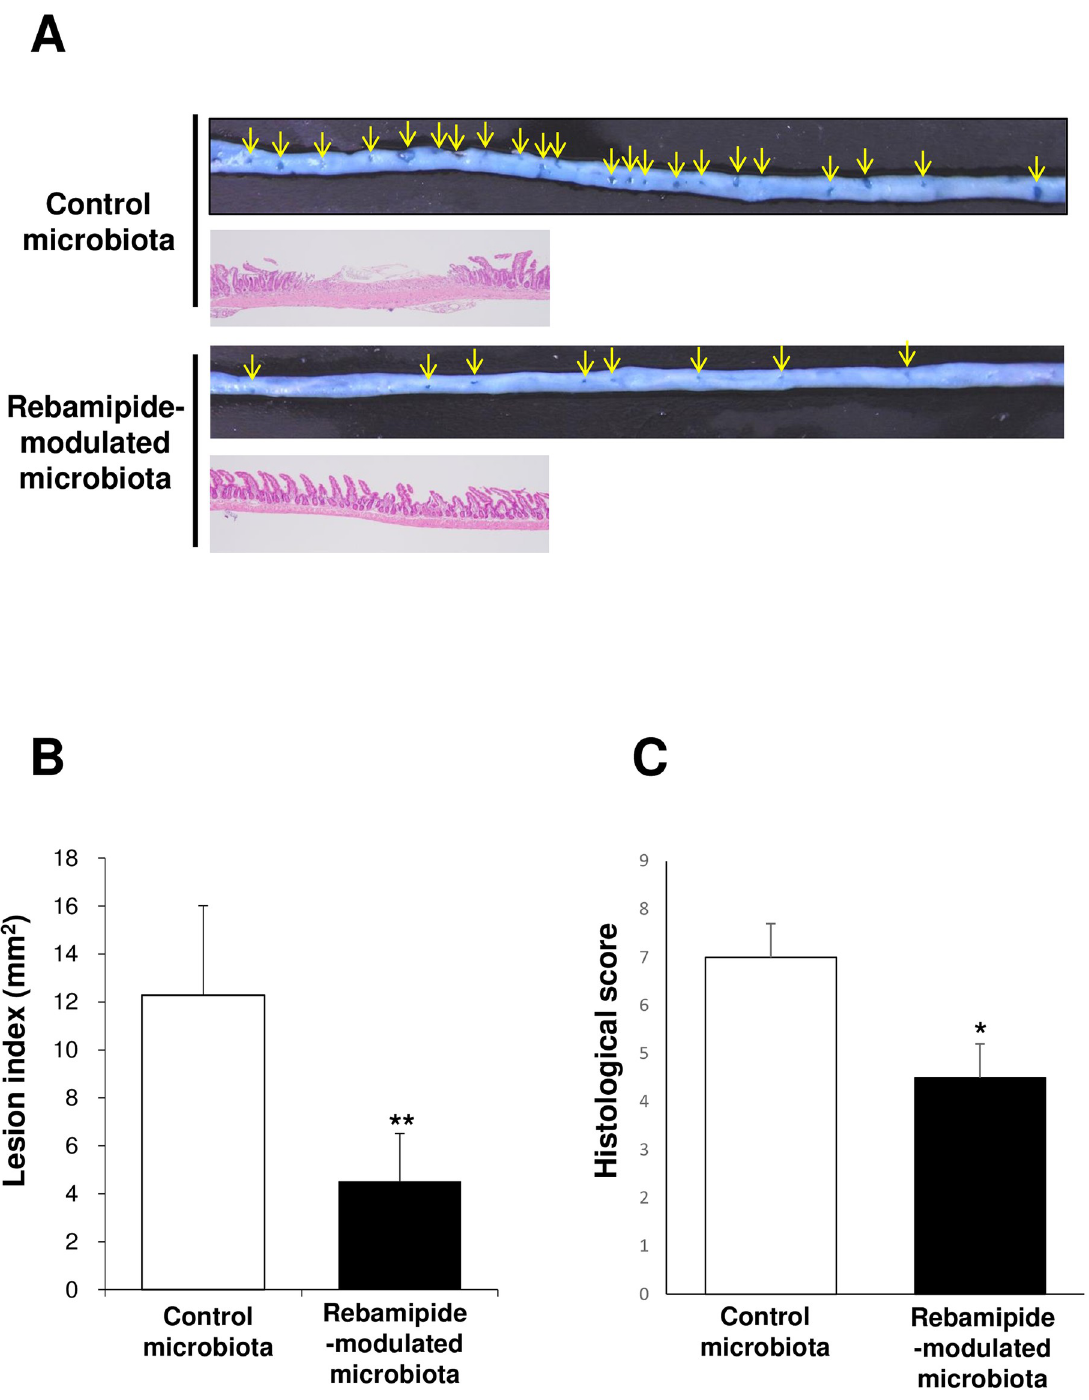
Fig 2. Small intestinal damage after indomethacin administration and the inhibitory effects of rebamipide-modulated small intestinal microbiota on indomethacin-induced small intestinal damage. A. Typical macroscopic and histological image of indomethacin-induced small intestinal damage. Damaged mucosa (arrows) was stained dark blue with 1% Evans blue. B. Lesion indices of indomethacin-induced small intestinal damage. C. Histological evaluation of indomethacin-induced small intestinal damage. Ct: control microbiota group Reb: rebamipide-modulated microbiota group. Each column represents the mean ± standard error of the mean (S.E.M.). N = 5–6. � p < 0.05 and �� p < 0.01 vs. control microbiota group.